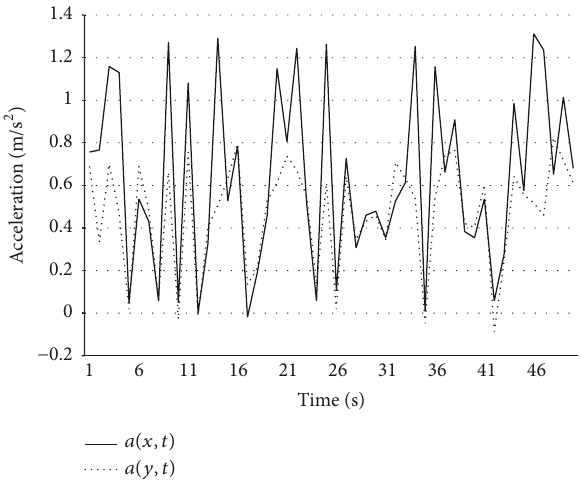
Figure 2: Acceleration in 𝑥 and 𝑦 direction of a real-world driver measured during 10 seconds while the vehicle is at